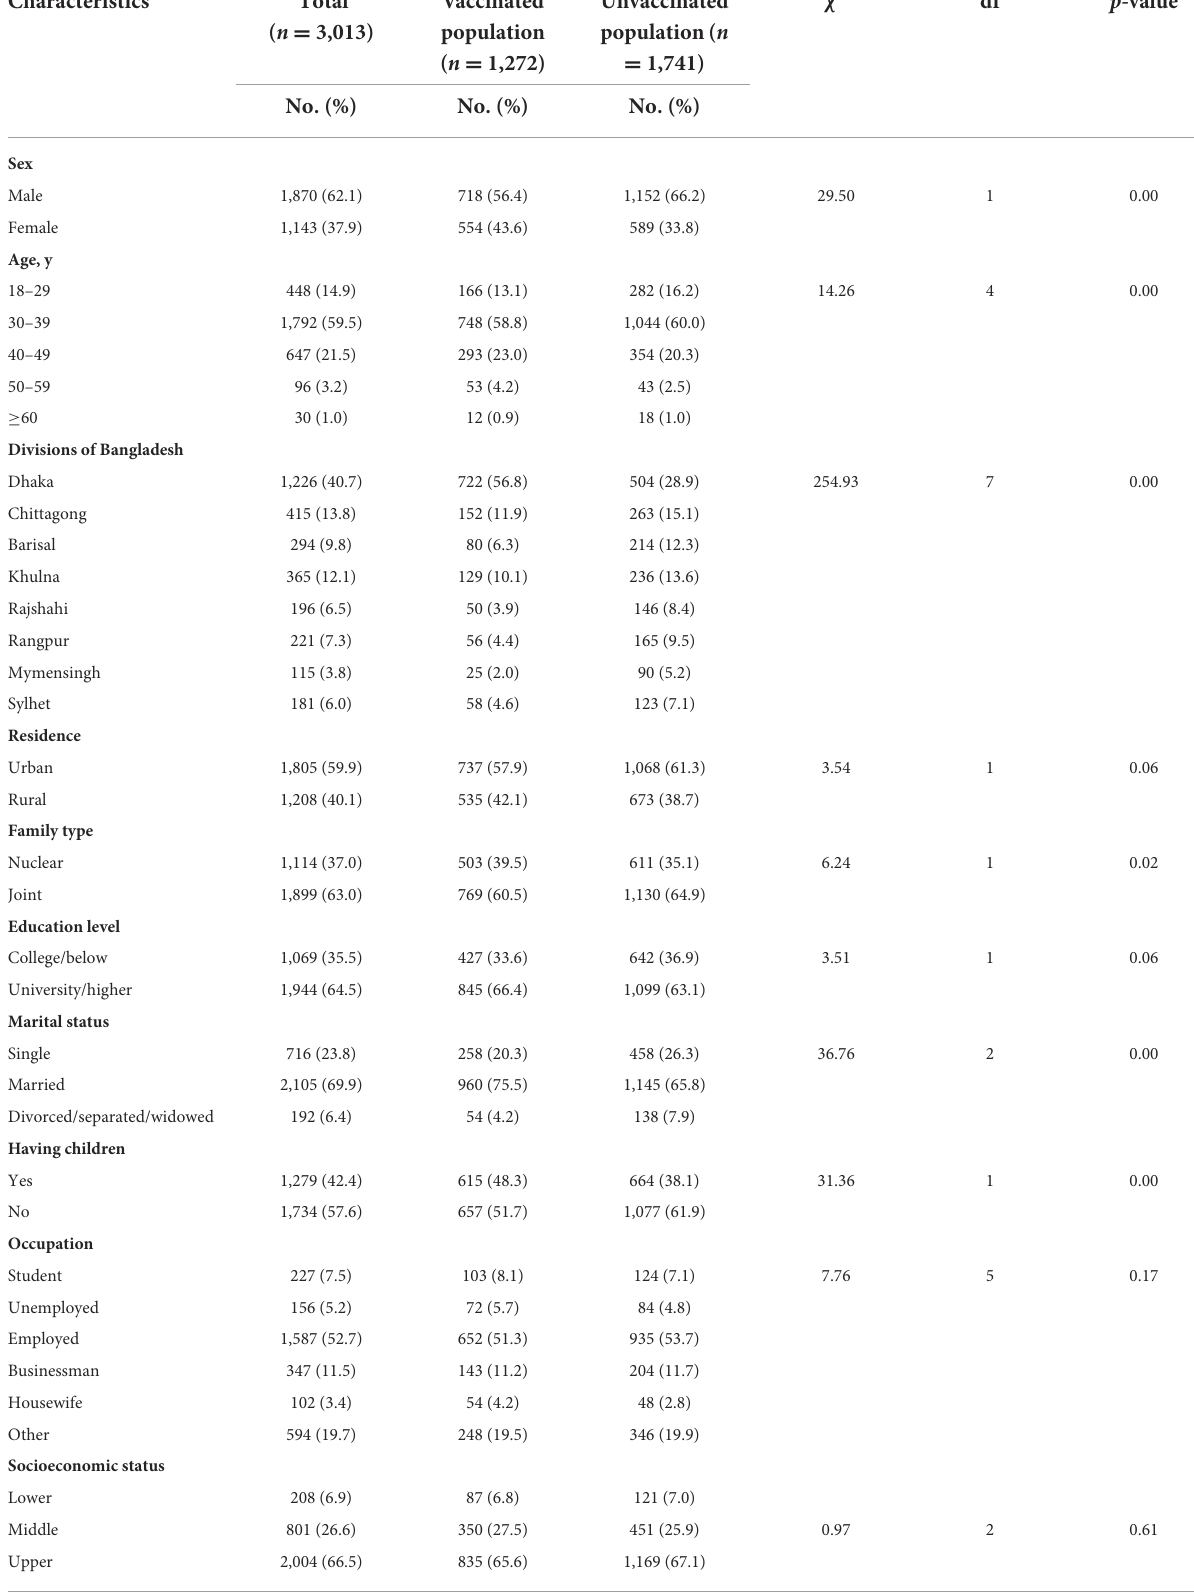
TABLE 1 Demographic, health, and COVID-19-related characteristics in vaccinated and unvaccinated populations against COVID-19 infection. Characteristics Total